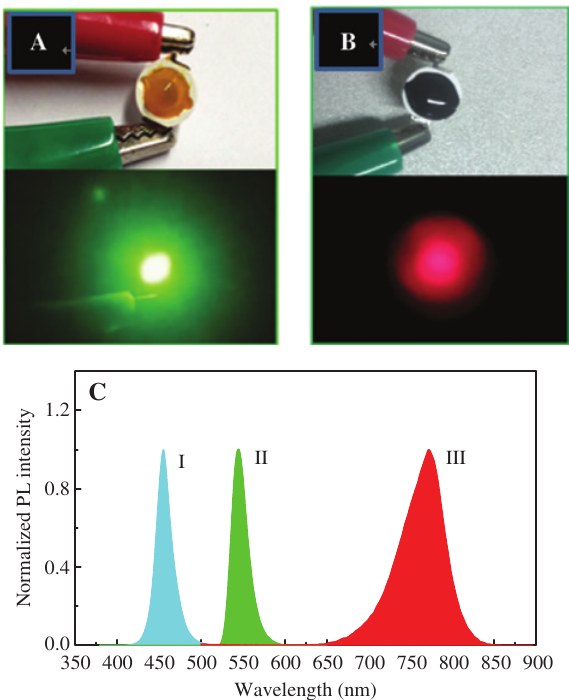
/PDMS-urea gel and 3 / 3